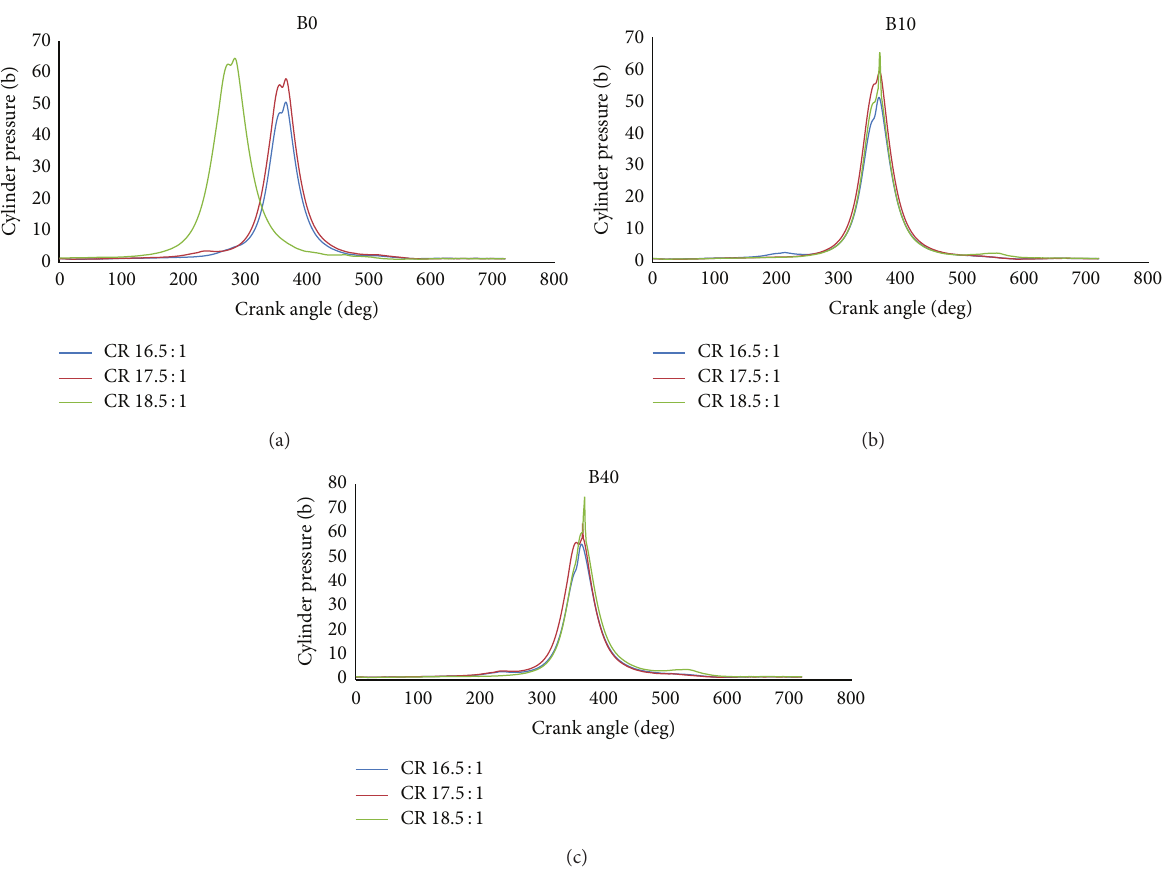
Figure 4: Pressure versus crank angle for B0, B10, and B40 fuel at 75% of rated load for different compression